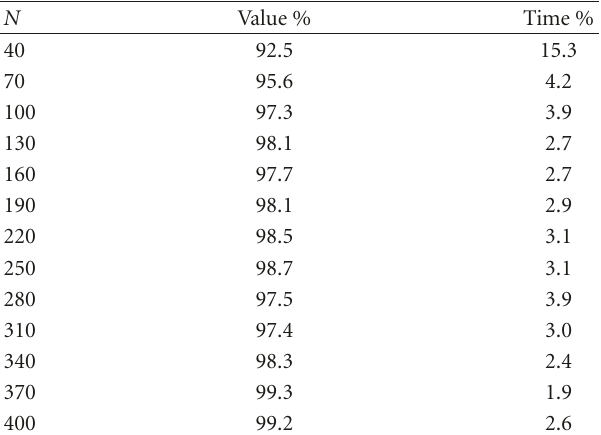
Table 2: Performance comparison of Branch-and-bound and a Heuristic algorithm in terms of total achieved throughput and execution